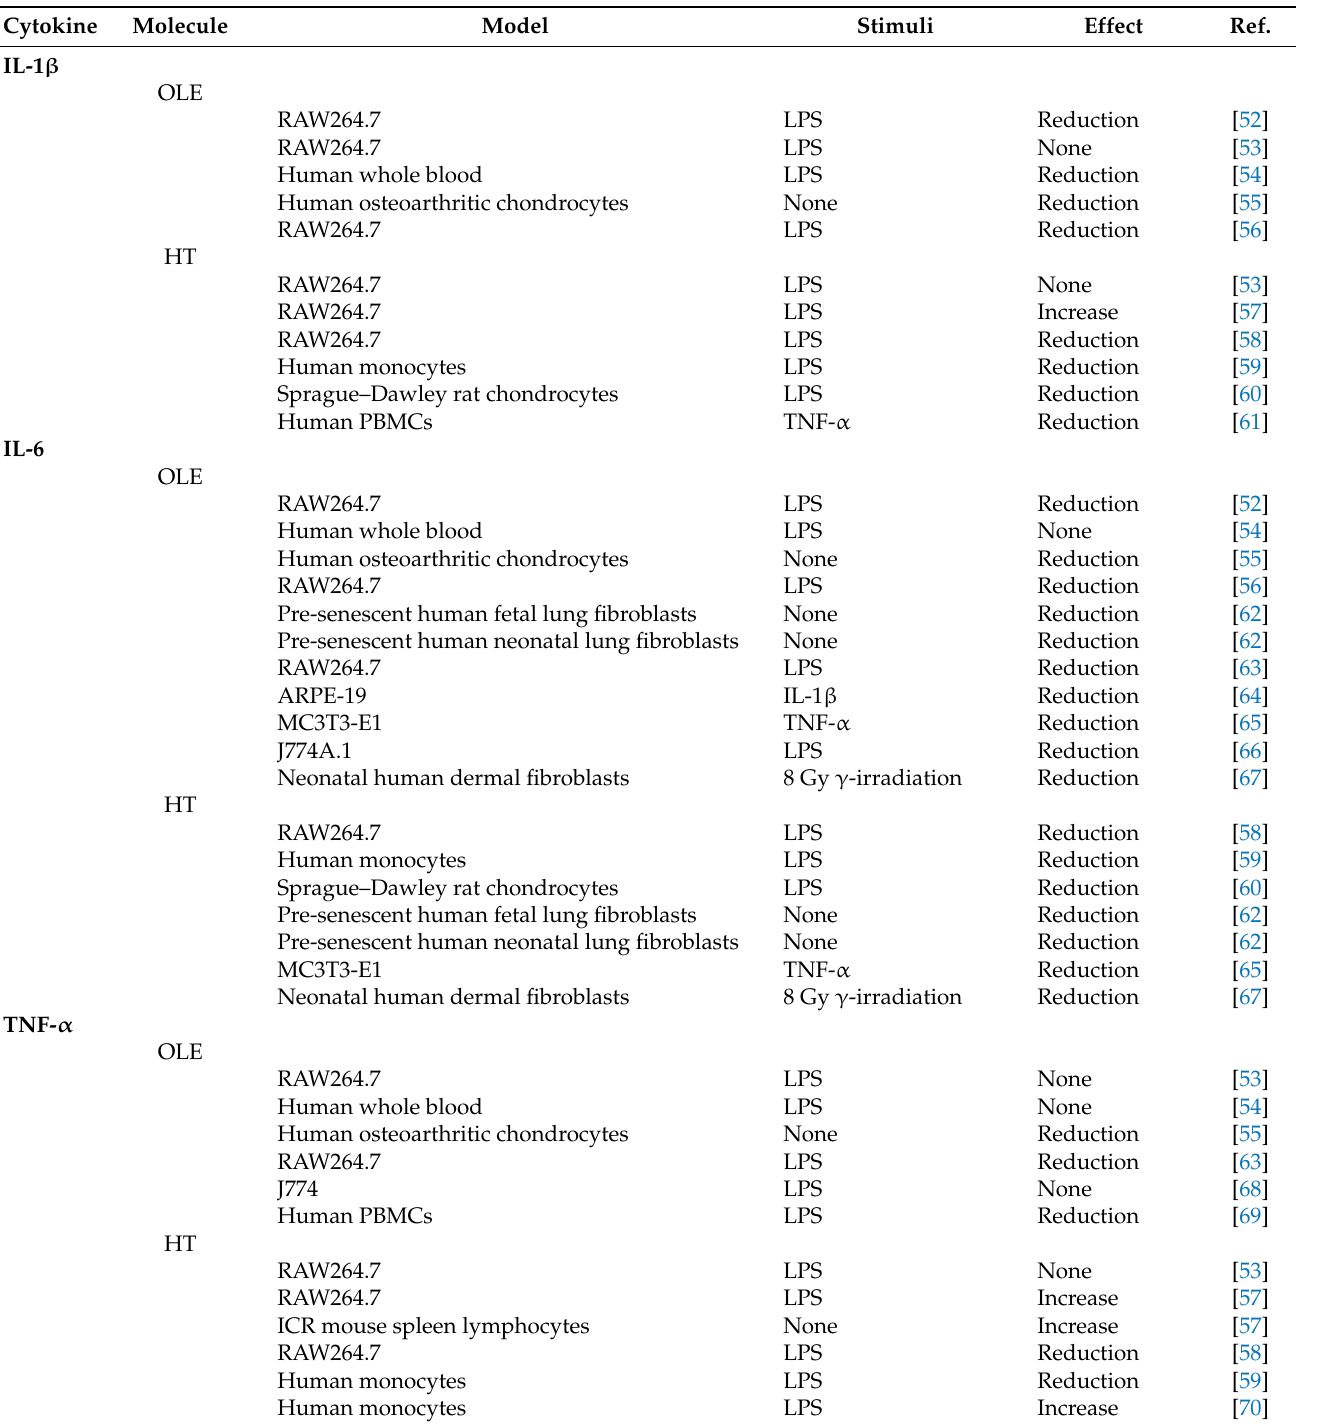
Table 1. Effects elicited by OLE and HT on pro- and anti-inflammatory cytokines in vitro. Model Stimuli